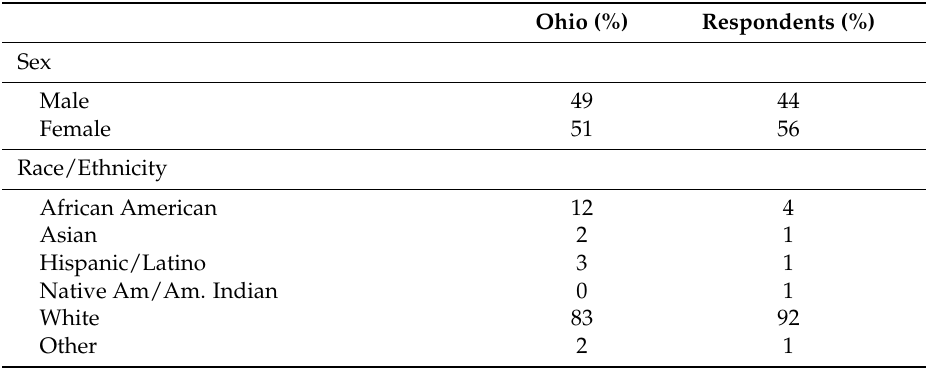
Table 1. Demographic comparison of Ohio population and survey